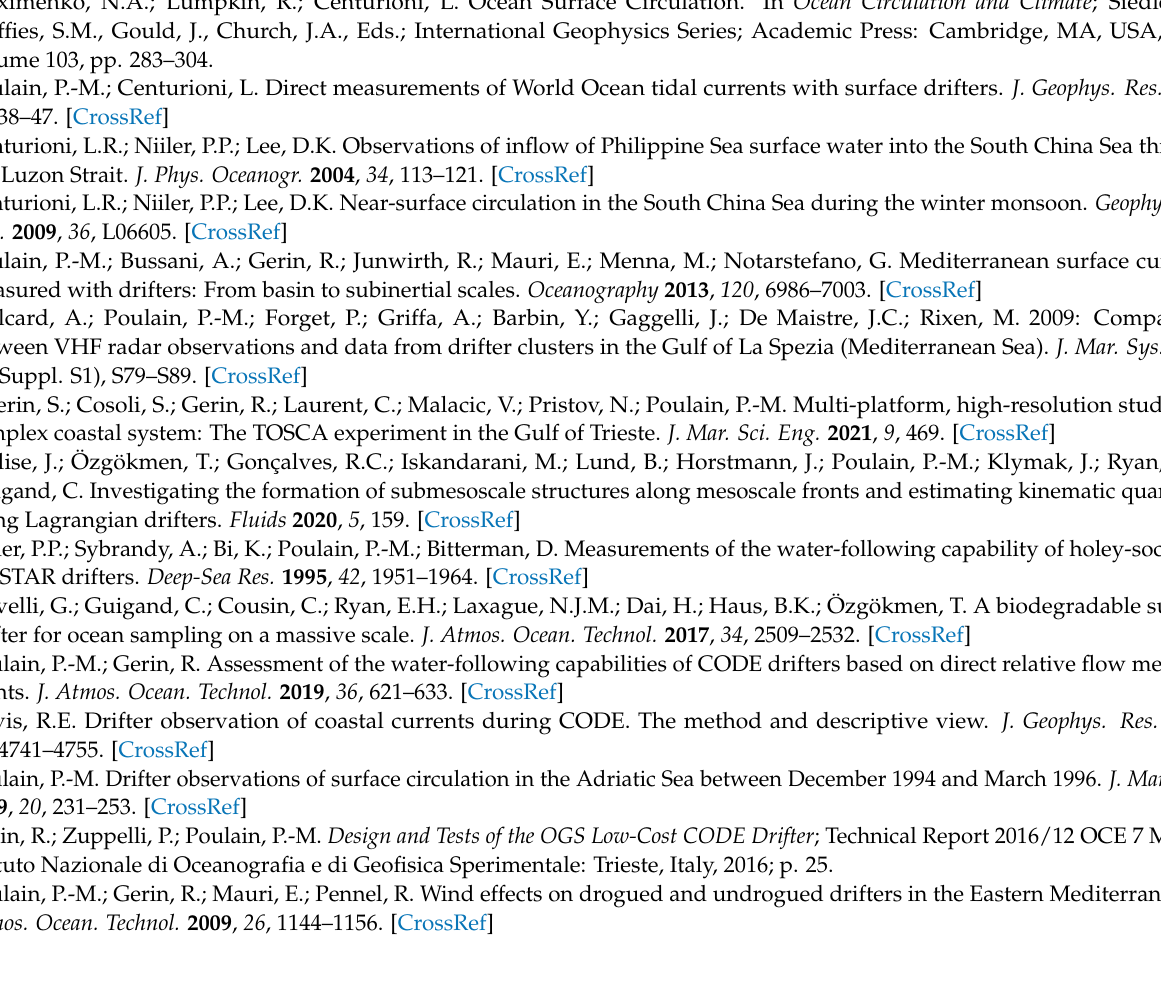
Figure A2. Normalized histograms of the magnitude of the velocity difference using low-pass filtered drifter data and a separation distance ≤ 1 km: 1099 CARTHE–CARTHE pairs in CALYPSO 2018–2019 (gray bars) and 154 CARTHE–SVP pairs in CALYPSO 2019 (white bars).